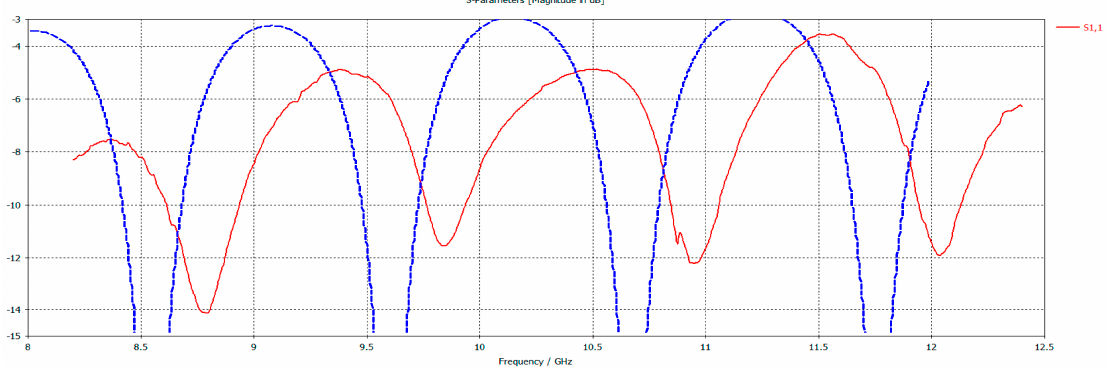
Figure 5. Reflection Coefficient in dB versus frequency by 3D (red continuous line) and plane wave (blue dashed line) simulation results with the mosaic.